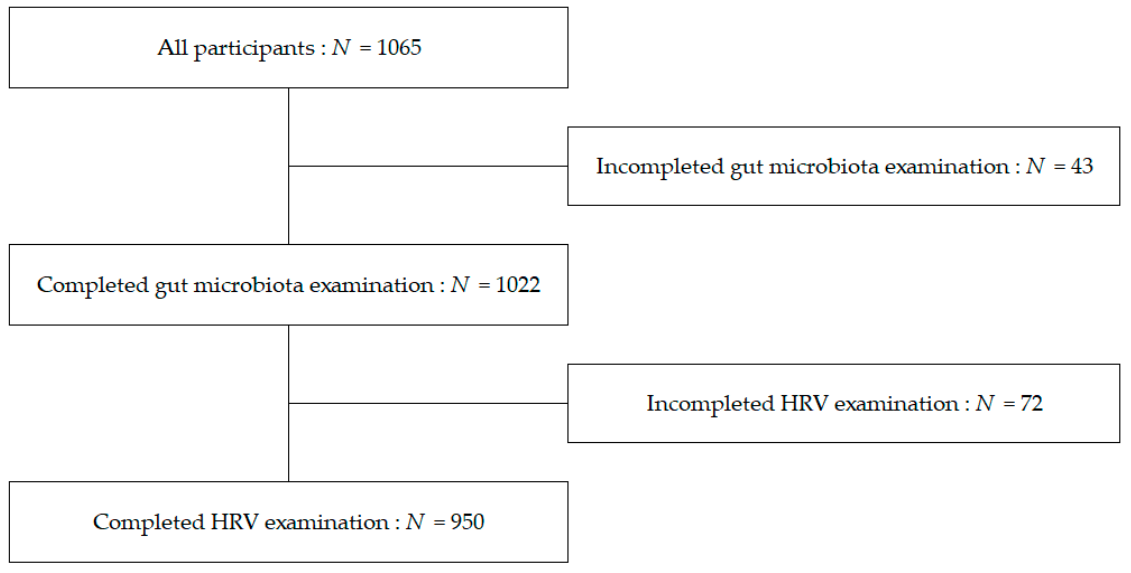
Figure 1. Number of examinations completed.